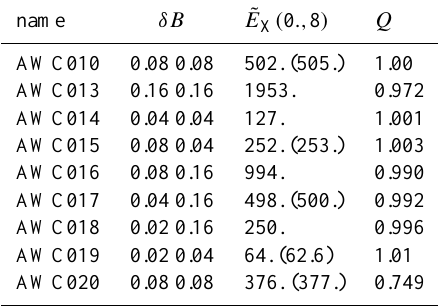
Table 3. Test of the bi-linear dependency of the maximal Fourier transform value ˜ E X (k) of E X as a function of the initial Alfv´en waves amplitudes. The initial Alfv´en wave amplitudes δB 1 and δB 2 are given in the column δB . For a bilinear dependency, the factor Q = ˜ E 0 ., 8 /δB 1 × δB 2 must be constant. In the column ˜ E x ( 0 ., 8 ) , the values in parenthesis correspond to simulations with 50 particles per cell, the other values correspond to the simulations with 400 particles per cell. When there is no difference, only one value is given.